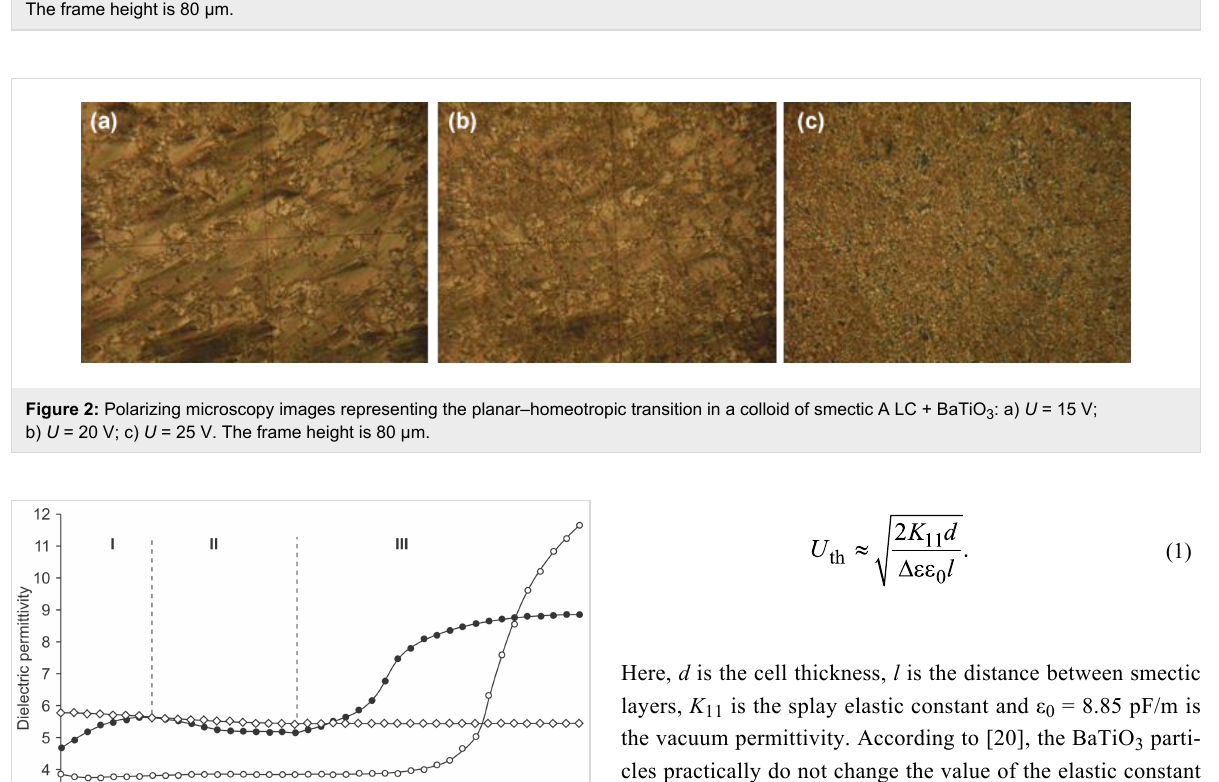
Figure 1: Polarizing microscopy images representing the planar–homeotropic transition in pure smectic A LC: a) U = 25 V; b) U = 35 V; c) U = 45 V. The frame height is 80 μ m.